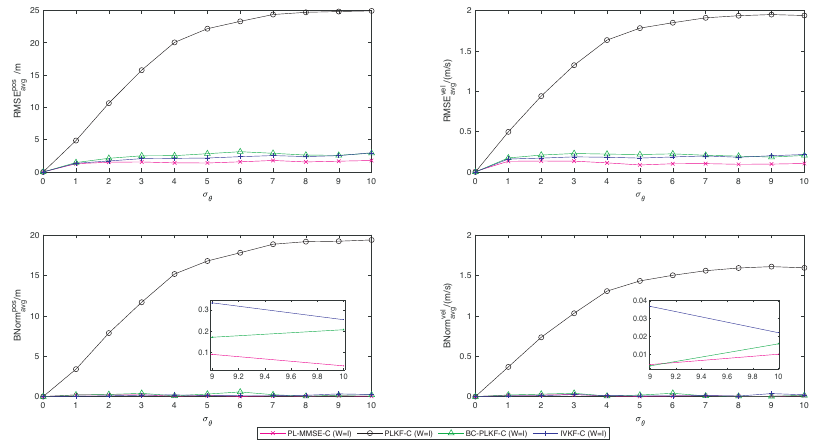
Figure 6. Time-averaged RMSEs, BNorms and bearing noise standard deviation for the four algo- rithms combined with the mean square method.